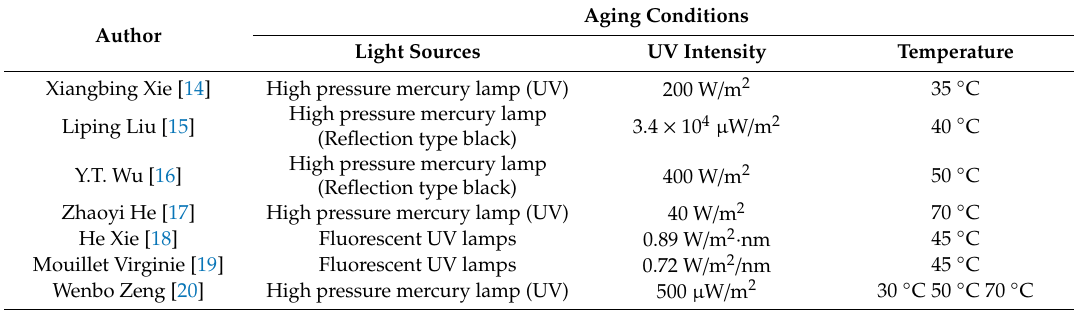
Table 1. Aging conditions of previous